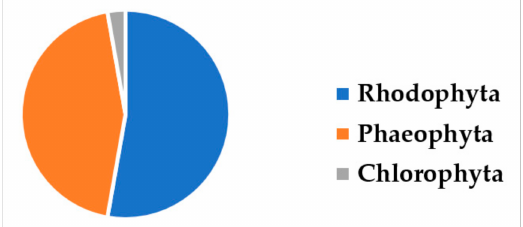
Figure 2. Number of publications on the influence of abiotic factors on callus induction according to taxonomic group.